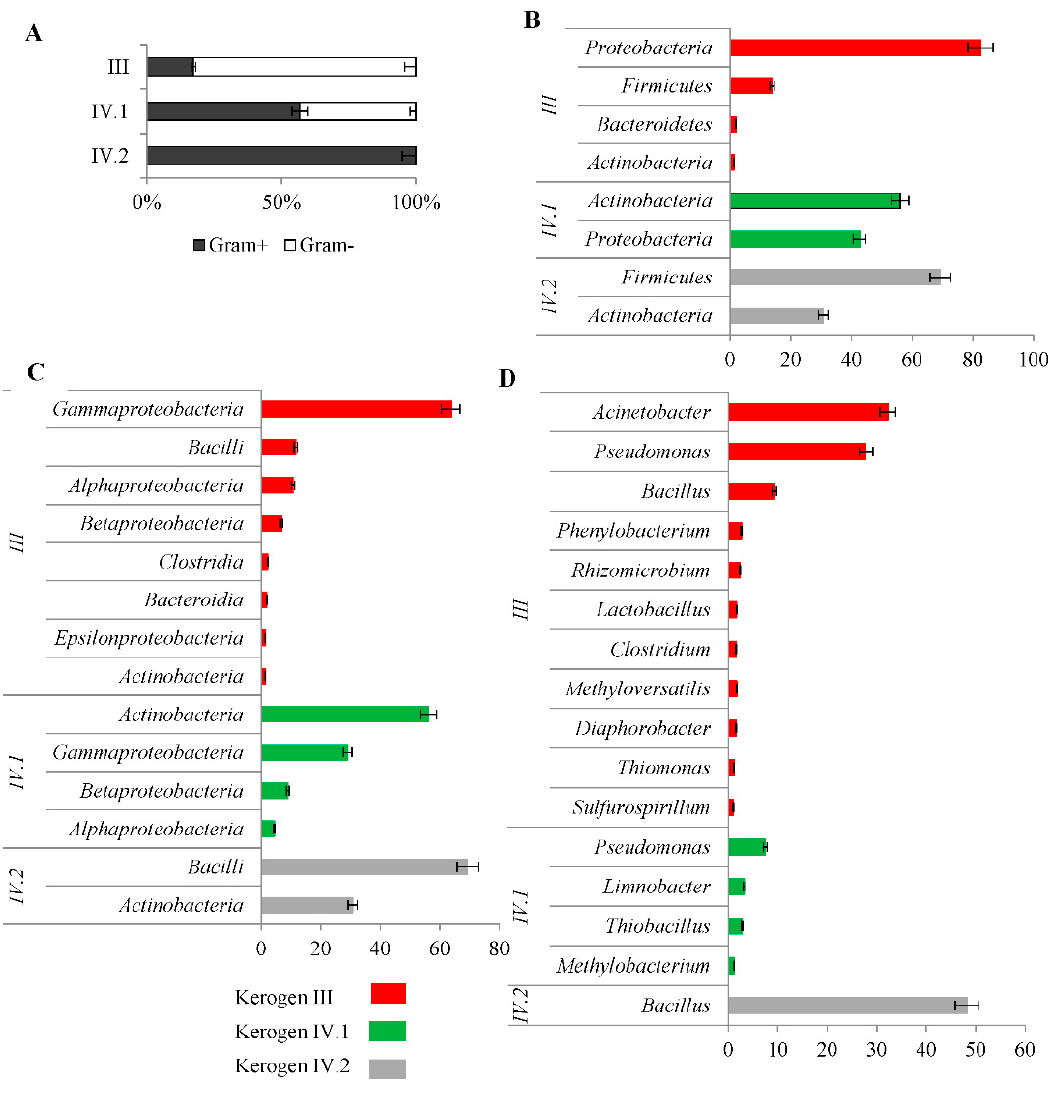
Figure 5. Taxonomic composition of the bacterial communities identified in the shale rock samples enriched in kerogen III, IV.1, and IV.2. ( A ) Content of Gram-positive and Gram-negative bacteria. ( B ) Dominating (>1%) phyla. ( C ) Dominating (>1%) classes. ( D ) Dominating (>1%) genera. The error bars represent standard